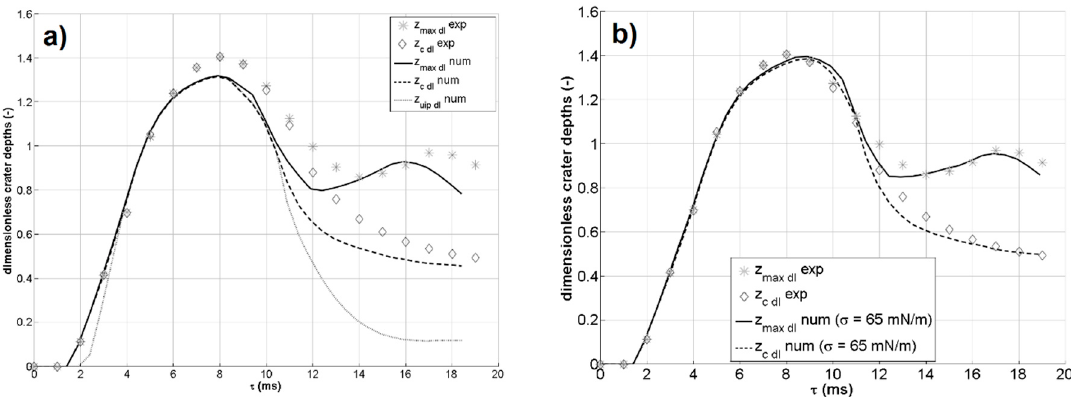
Figure 6. Dimensionless z max , z c and z uip extracted from the experiments and from the numerical simulations for case A (w = 1.0 m/s): ( a ) the results using σ = 71 mN/m; ( b ) the results using σ = 65 mN/m.